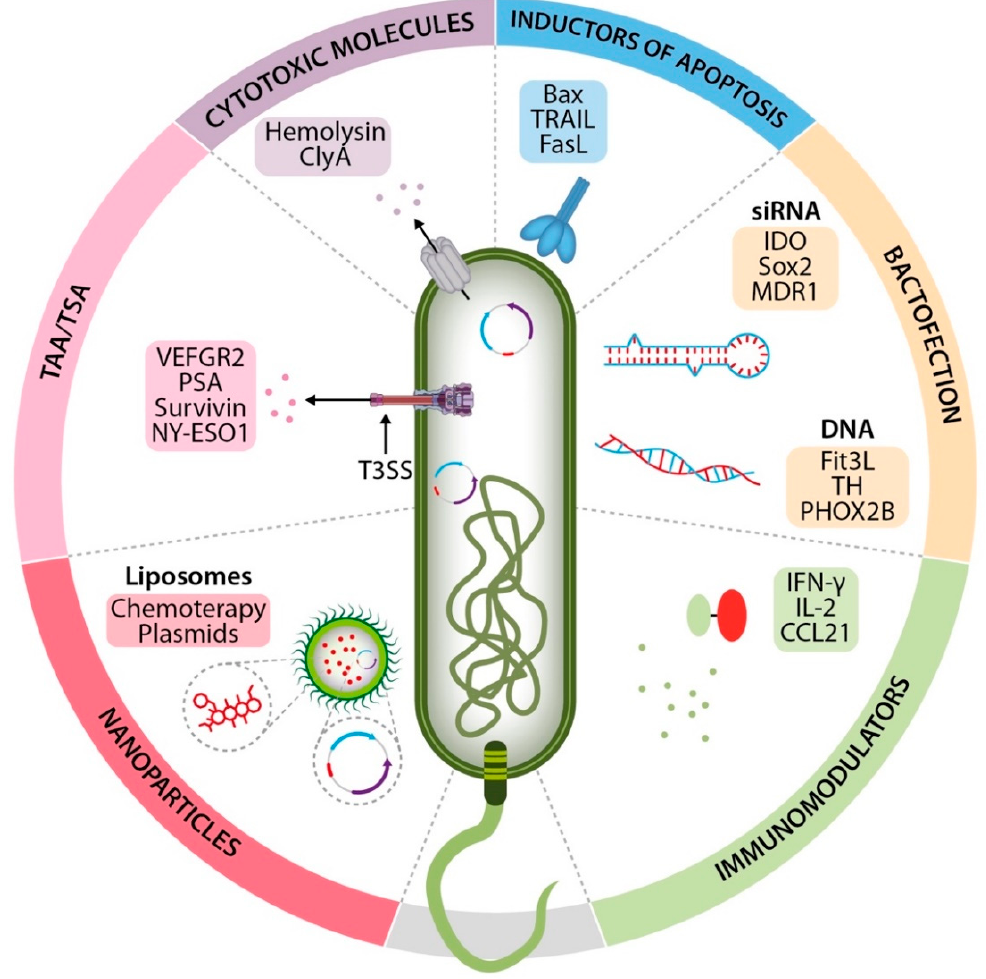
Figure 2. Salmonella enterica as a delivery system of heterologous molecules in cancer therapy. Salmonella enterica ’s tropism for the tumor microenvironment and antigen-presenting cells (APC), as well as its ability to become a molecule factory within the tumor microenvironment, has allowed its use as a delivery system of heterologous molecules with antitumor properties such as: tumor- associated antigens or tumor-specific antigens, cytotoxic molecules, immunomodulating molecules, inducers of apoptosis, nucleic acids, and